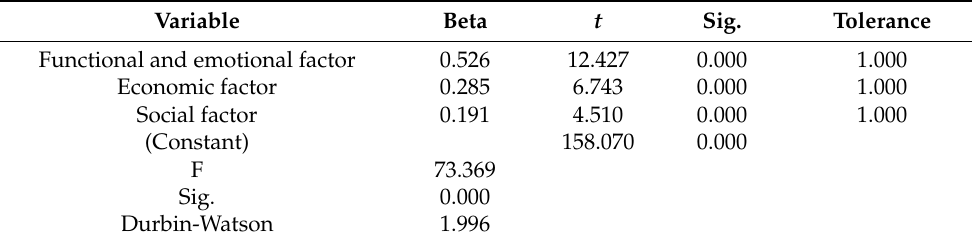
Table 2. Relationship of perceived value and satisfaction.